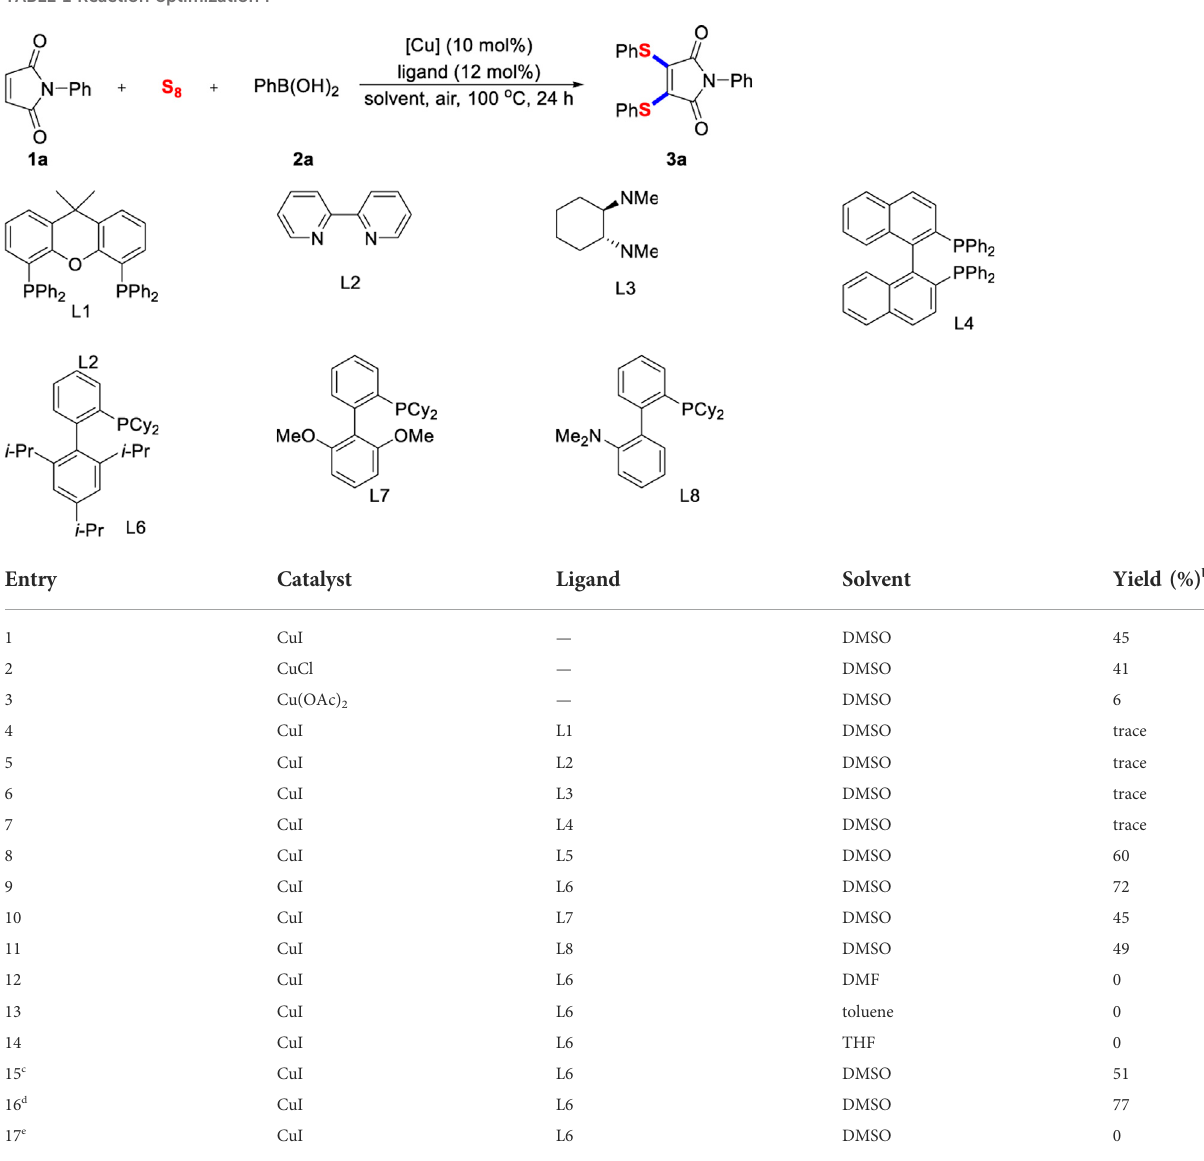
TABLE 1 Reaction optimization a